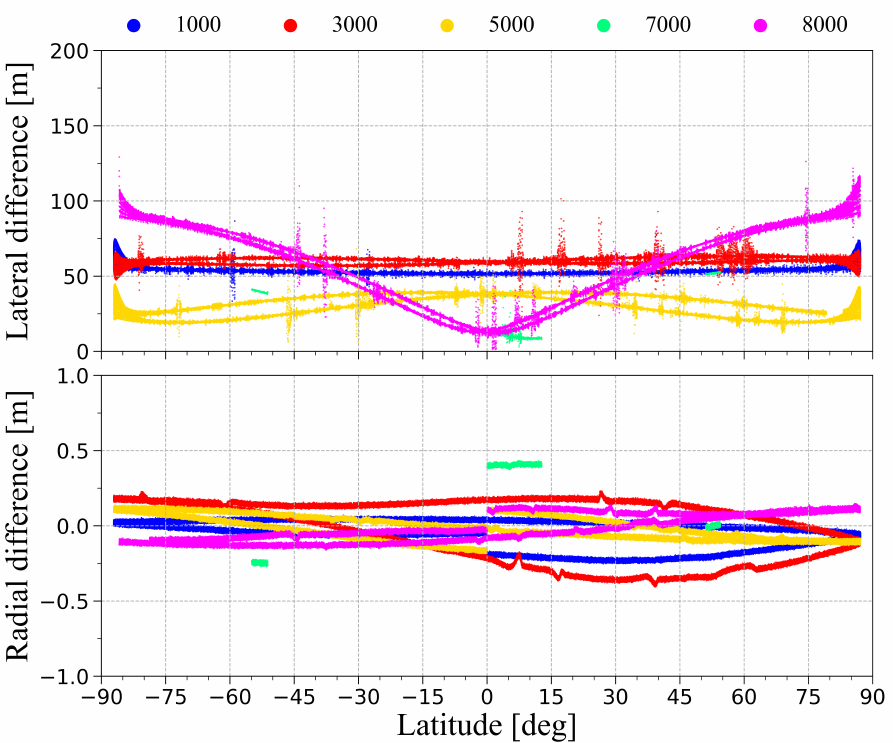
Figure 5. Lateral ( top ) and radial ( bottom ) differences of PAM with Mars as the observer using updated auxiliary information with respect to the PEDR footprint locations for the selected nadir profiles.